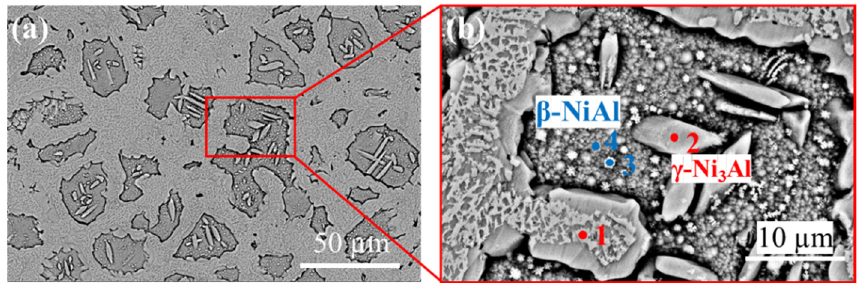
Figure 1. SEM/BSE microstructure of the as-received NiCrAlYHf alloy ( a ) and local enlarged image ( b ).